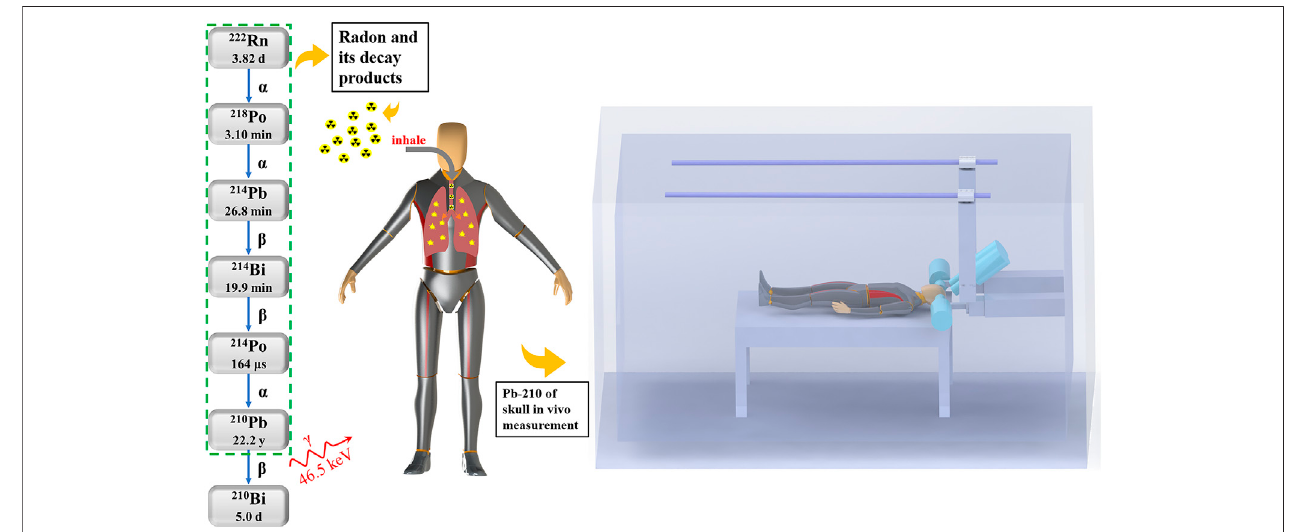
FIGURE 1 | Schematic diagrams of the radon decay chain, inhalation of radon and its decay products, and the Pb-210 in vivo measurement device, where four high purity germanium (HPGe) detectors are positioned around the head of a tested person inside the shielding room.